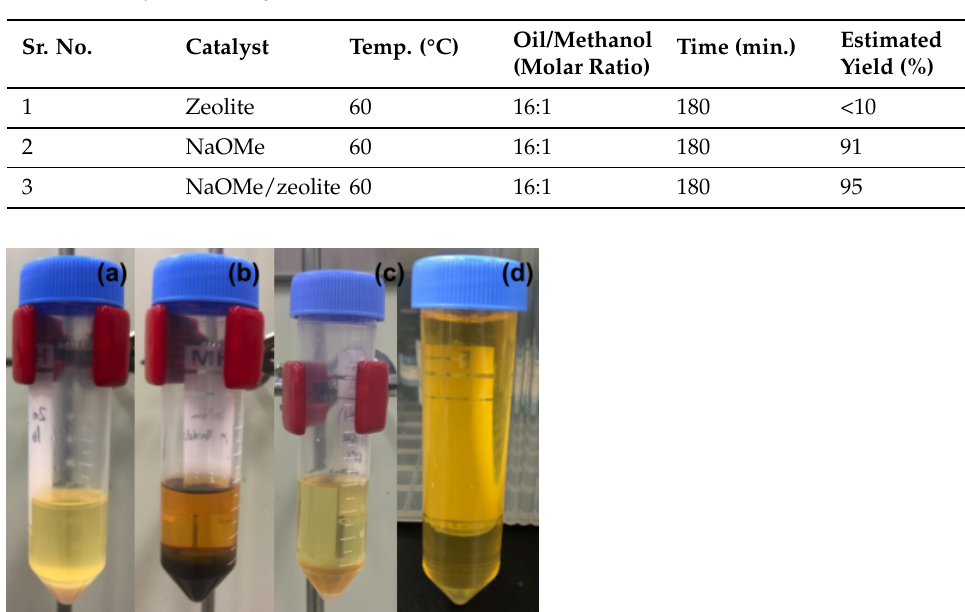
Table 3. Catalyst screening for transesterification of WCO.